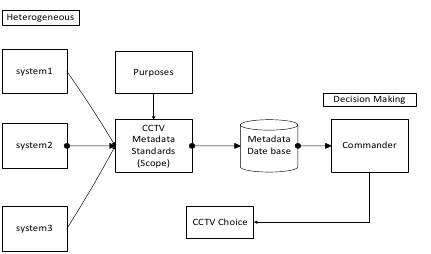
Figure 1. The use of standardized metadata and CCTV